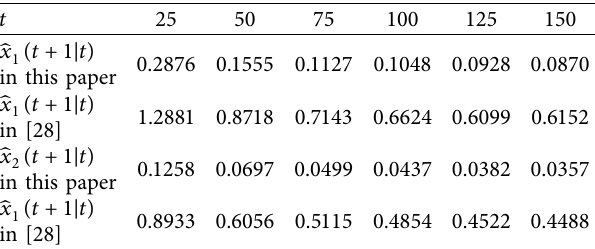
Table 2: Comparison between the MSEs of the predictor and that of the predictor in [28] ( t � 25 , 50 , 75 , 100 , 125 ,